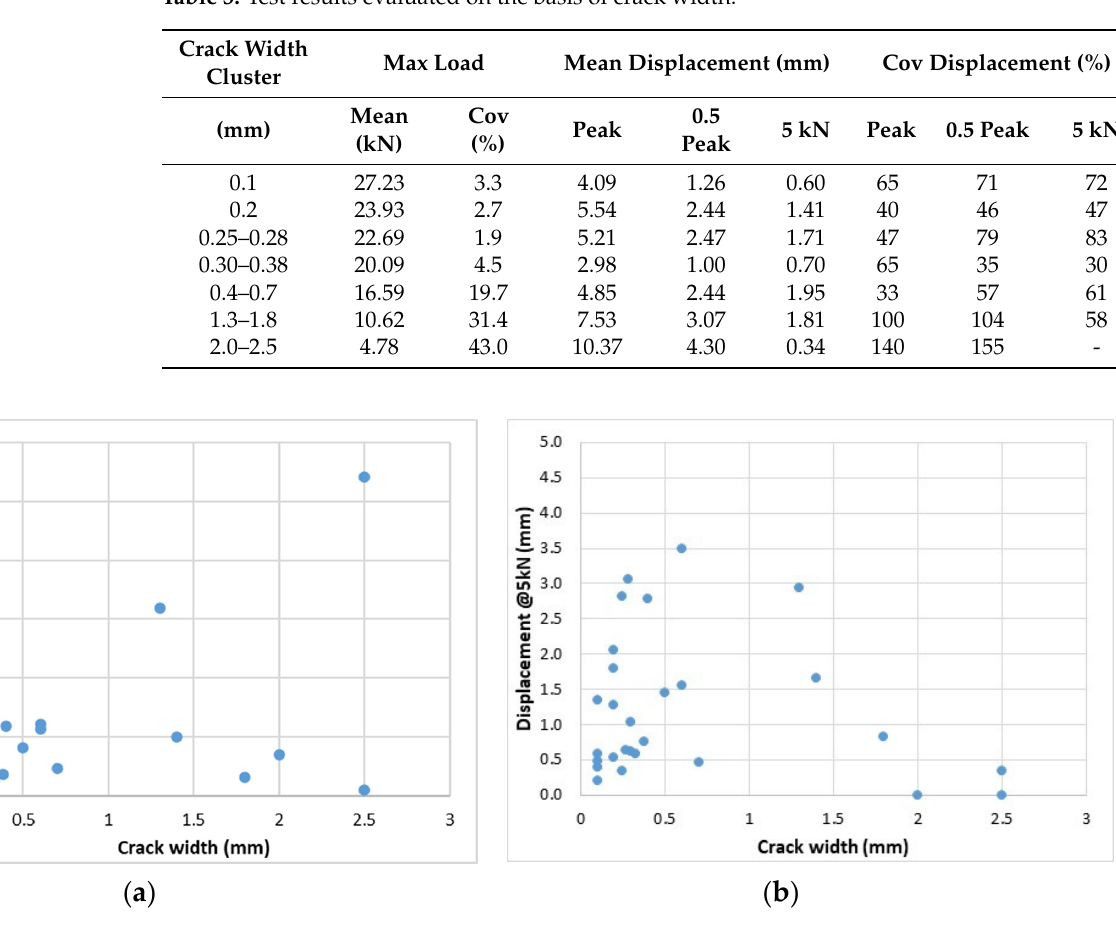
Figure 11. Displacement vs. crack width at the peak load ( a ) and at 5 kN ( b ). Table 3. Test results evaluated on the basis of crack